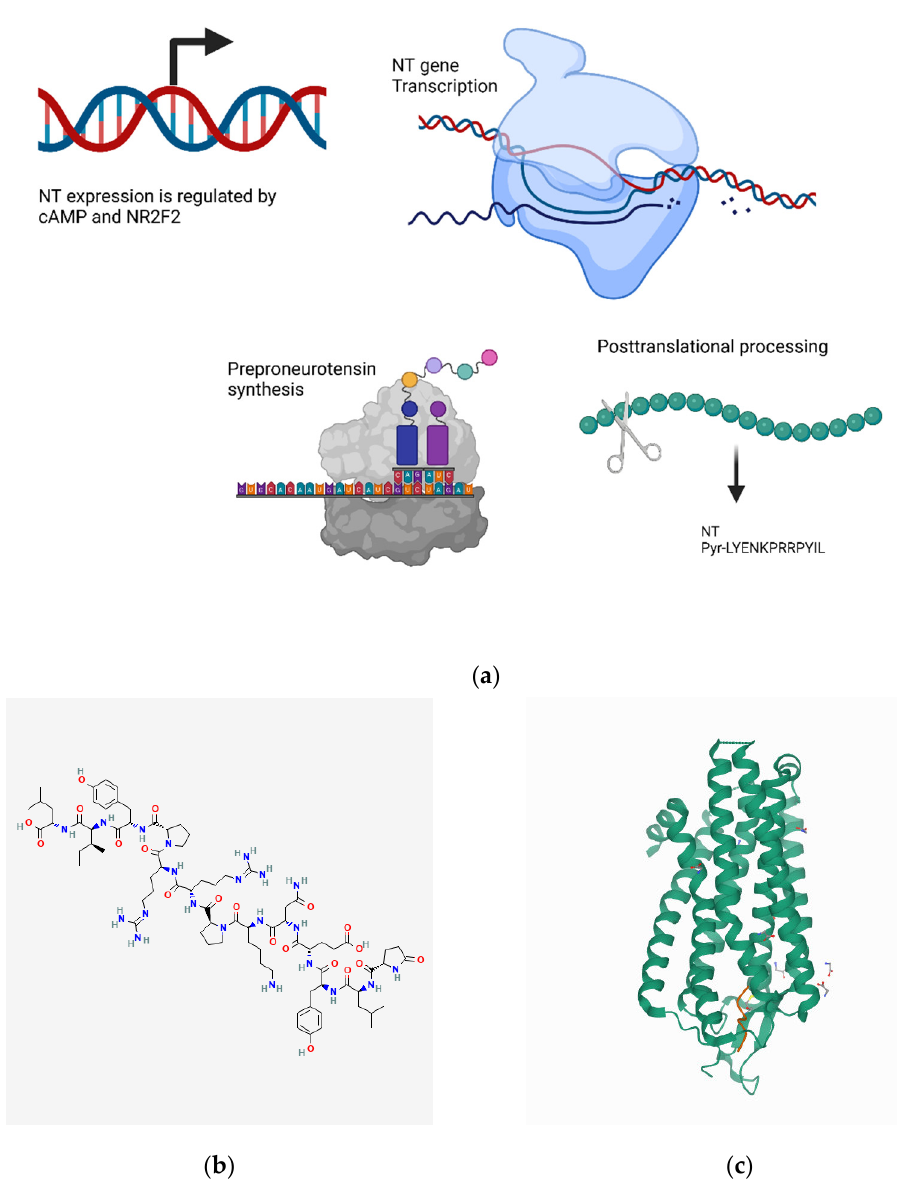
Figure 12. Neuropeptide NT and NTS1 receptor: ( a ) transcription and synthesis of NT (created with BioRender.com accessed on 22 October 2021); ( b ) 2D structure image of NT (https://pubchem.ncbi.nlm.nih.gov/compound/25077406#section=2D-Structure, accessed on 22 October 2021); ( c ) high-resolution structure of thermostable agonist-bound neurotensin receptor 1 mutant without lysozyme fusion. Image from the RCSB PDB (rcsb.org) of PDB ID 4BUO [576].